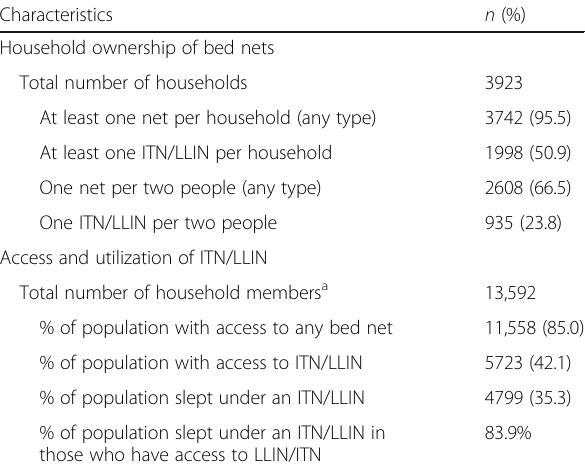
Table 3 Household ownership and utilization of bed nets among migrant population in RAI project areas of Myanmar, 2014